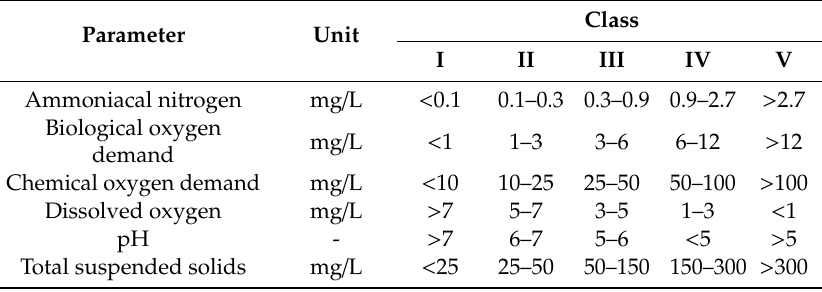
Table 5. DOE water quality index